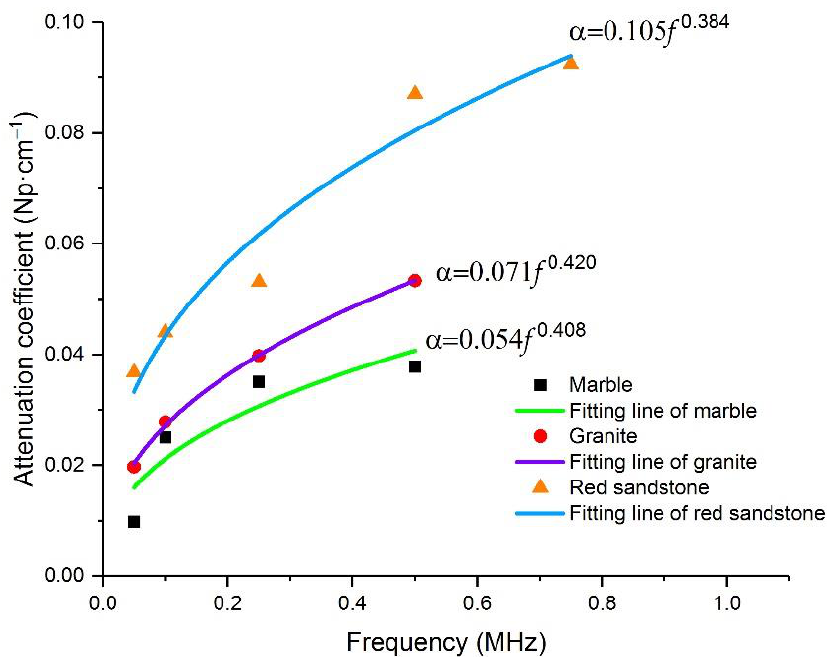
Figure 6. Measured attenuation coefficients of red sandstone, granite, and marble at different fre- quencies, and the fitted curves. It is obvious that the relationship between 𝛼 and 𝑓 has a similar form. Table 4. Fitting relationship between 𝛼 and 𝑓 .